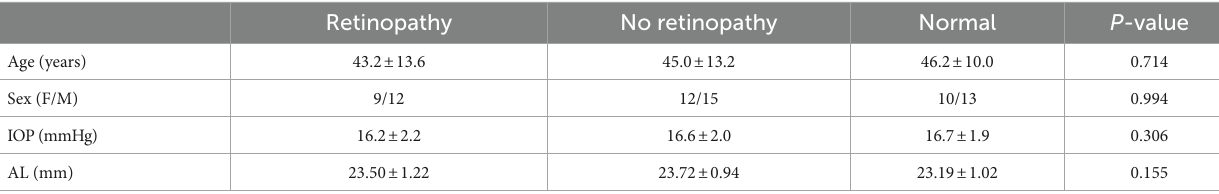
TABLE 1 Characteristics of the study population.